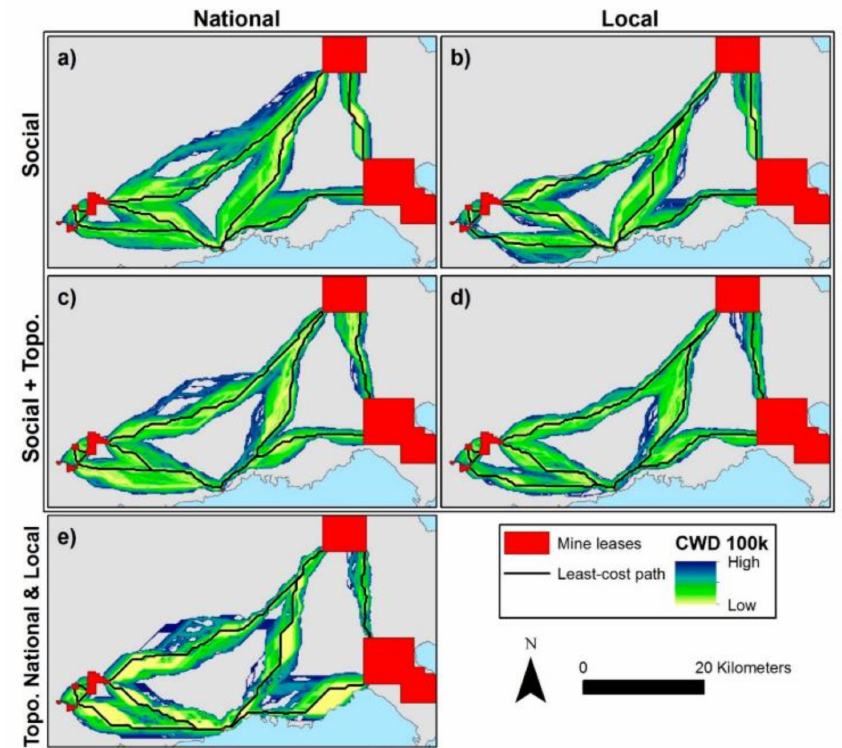
Figure 7. Infrastructure corridors identified with least-cost paths and corridor analysis for national and local groups ( a – d ). ( a , b ) Pathways and corridors identified where the resistance surface is based only on social values. ( c , d ) Pathways and corridors identified where the resistance surface is based on a combination of topography and social values. ( e ) Pathways and corridors identified only where the resistance surface is based on topography. Corridor width is based on a cost-weighted distance (CWD) threshold of 100,000 m